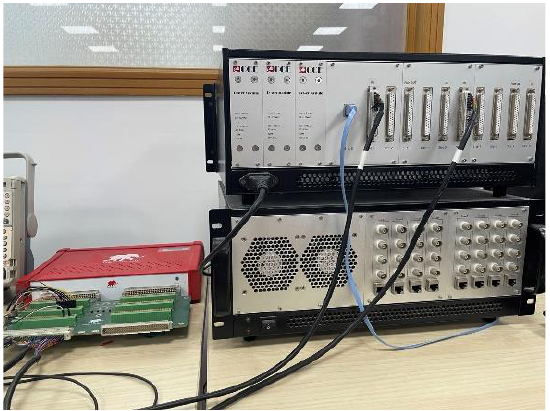
Figure 13. Experimental platform.